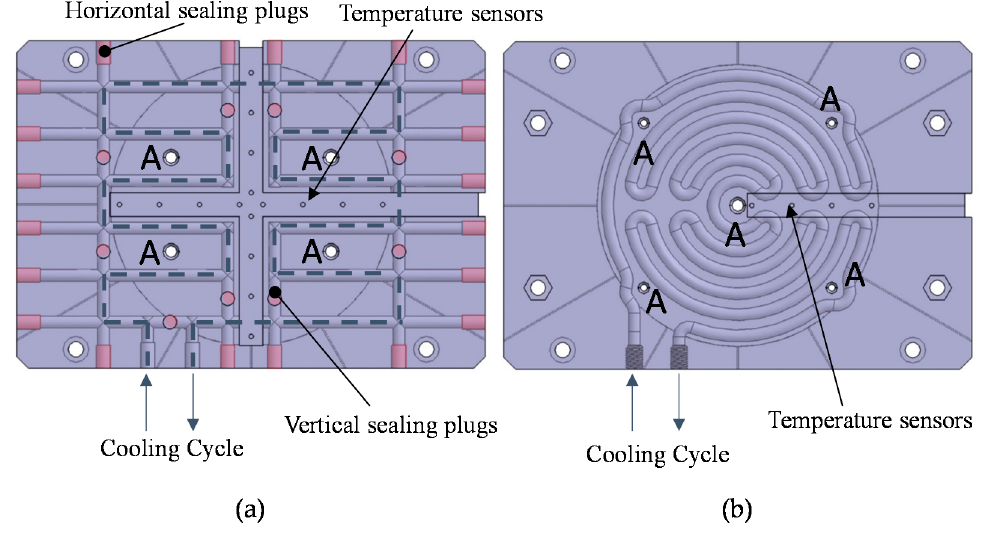
Figure 10. Ejector half disc tool designs: aluminum and steel ( a ) and Bluestone ( b ). Ejector pins are marked (A).